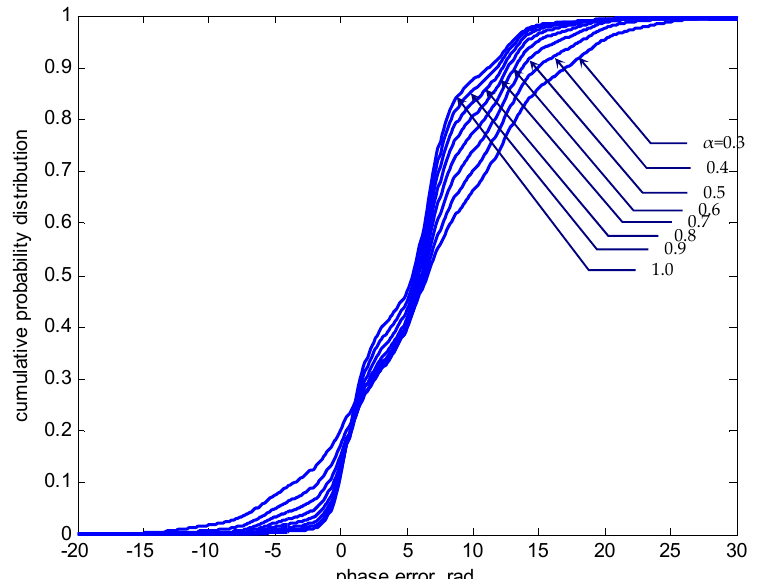
Figure 12. Nonmodulo-2 π phase-error cumulative probability distribution at τ = 10 for various SNR values ( γ = sin ( π /4 ) ).